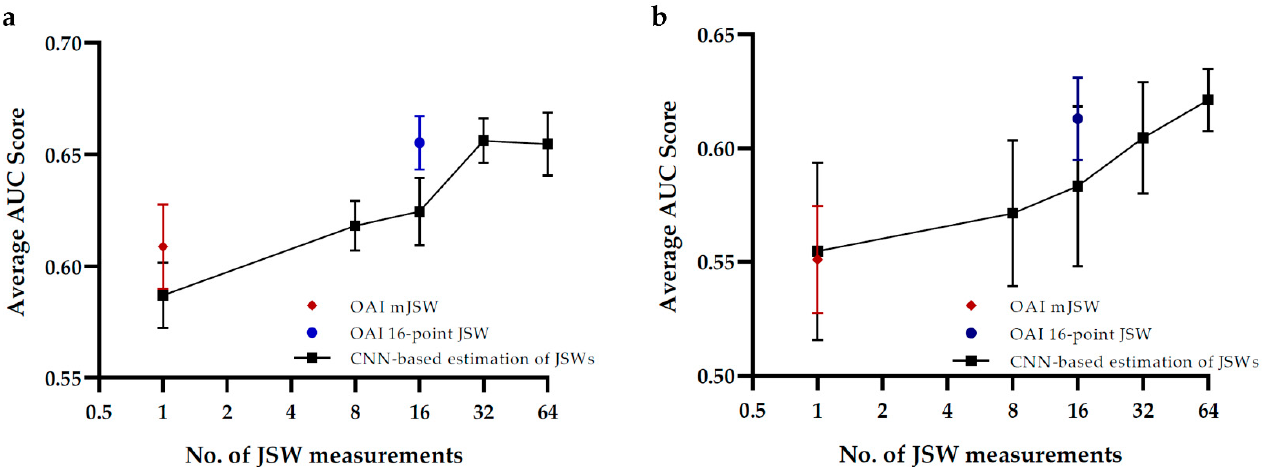
Figure 5. Performance of ( a ) KL-grades classification and ( b ) KOA progression prediction under different numbers of JSWs estimated by our CNN-based approach. The error bar represents the 95% confidence interval. The data points highlighted in red and blue represent the AUC scores of radiologist-measured minimum-JSW and 16-point JSWs, respectively.